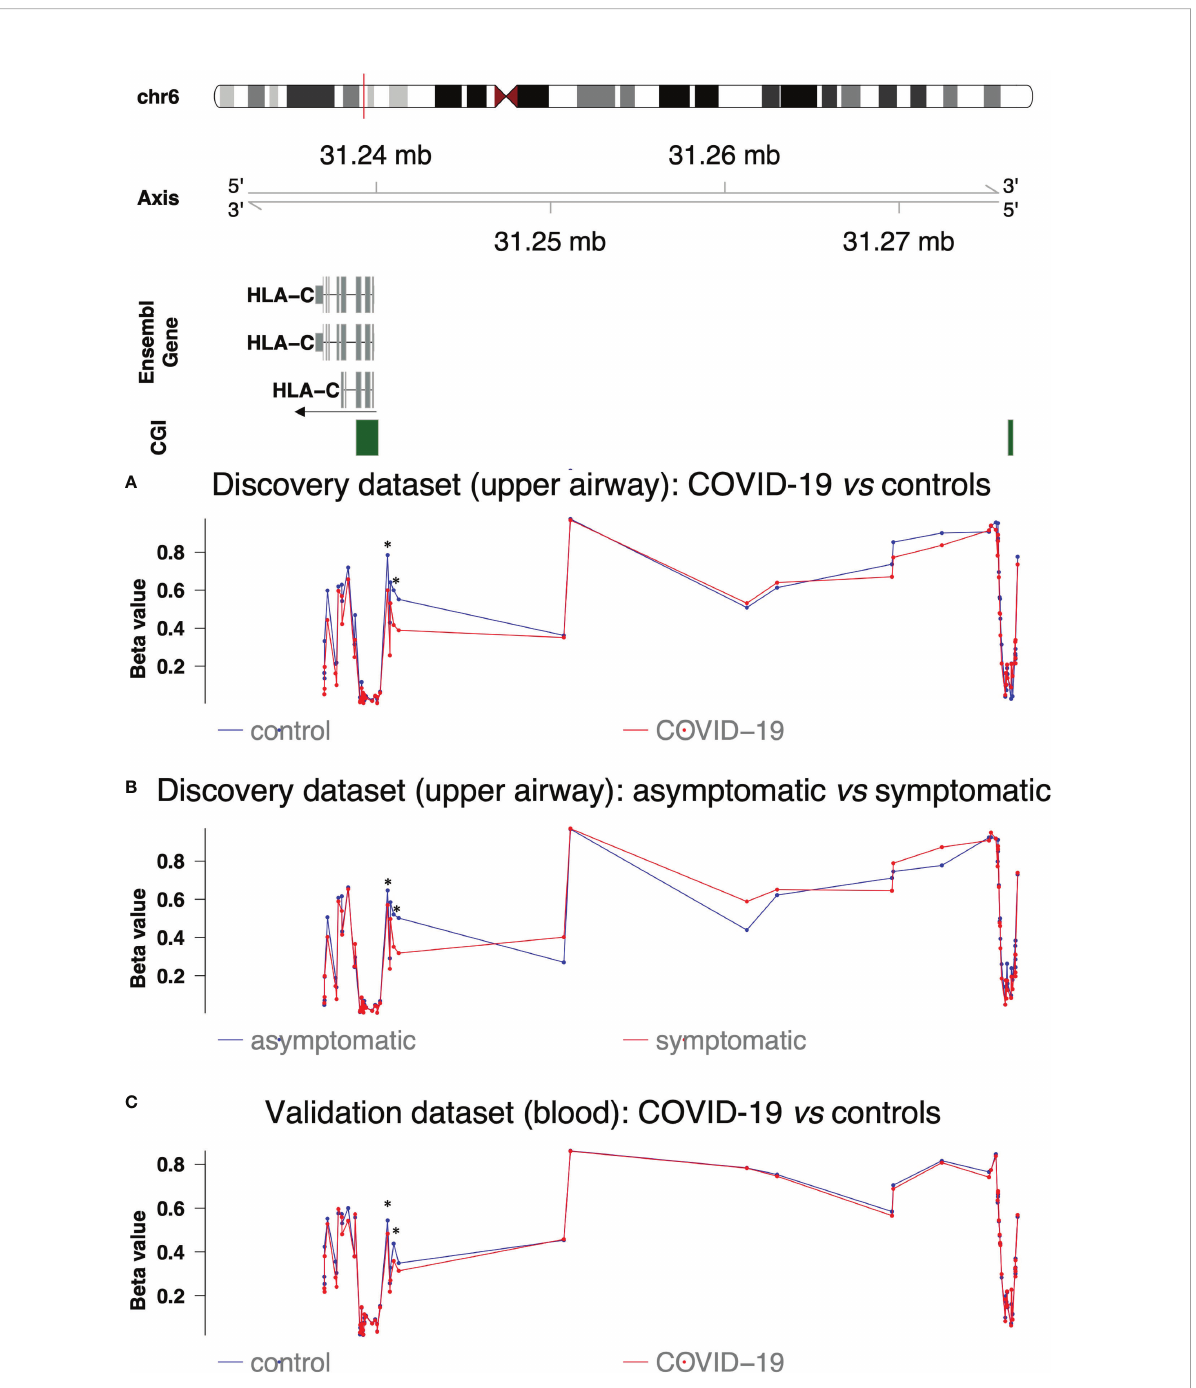
FIGURE 4 DNA methylation pro fi le of HLA-C regions. The upper part shows HLA-C isoforms, CpG islands and their chromosomic localization. The arrow indicates direction of transcription (A) DNA methylation pro fi le in the discovery dataset (upper airways) in COVID-19 patients (red line) and controls (blue line). (B) DNA methylation pro fi le in the discovery dataset (upper airways) in COVID-19 symptomatic (red line) and asymptomatic patients (blue line). (C) DNA methylation pro fi le in the validation dataset (blood) in COVID-19 patients (red line) and controls (blue line). Asterisks indicate the altered CpG sites identi fi ed in Castro de Moura et al.